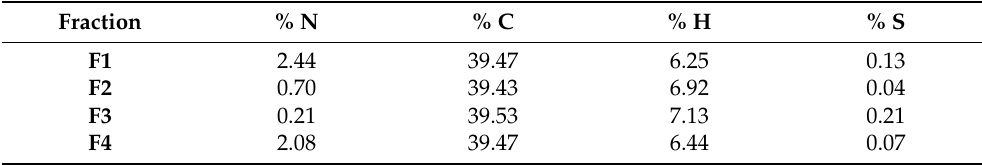
Table 2. Amounts of organic elements (% w/w ) in the fractions obtained from basidiocarps of G. resinaceum